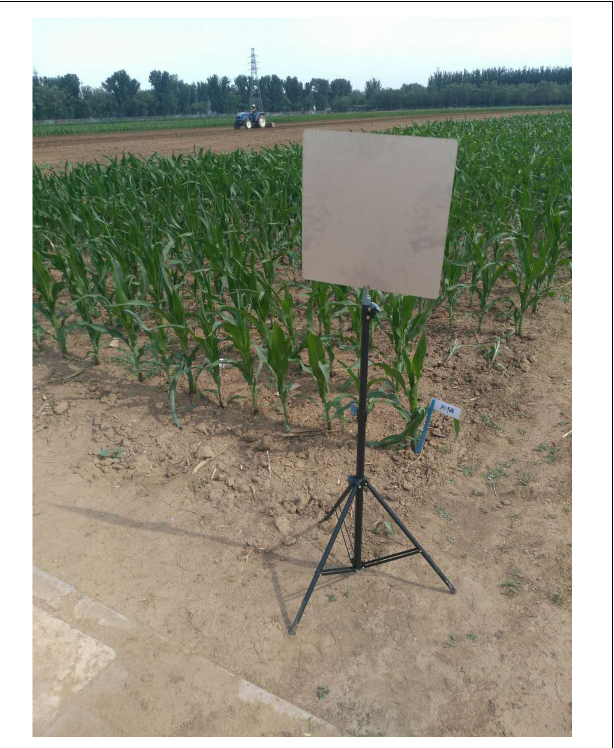
FIGURE 2 | Landmark in the experimental field.